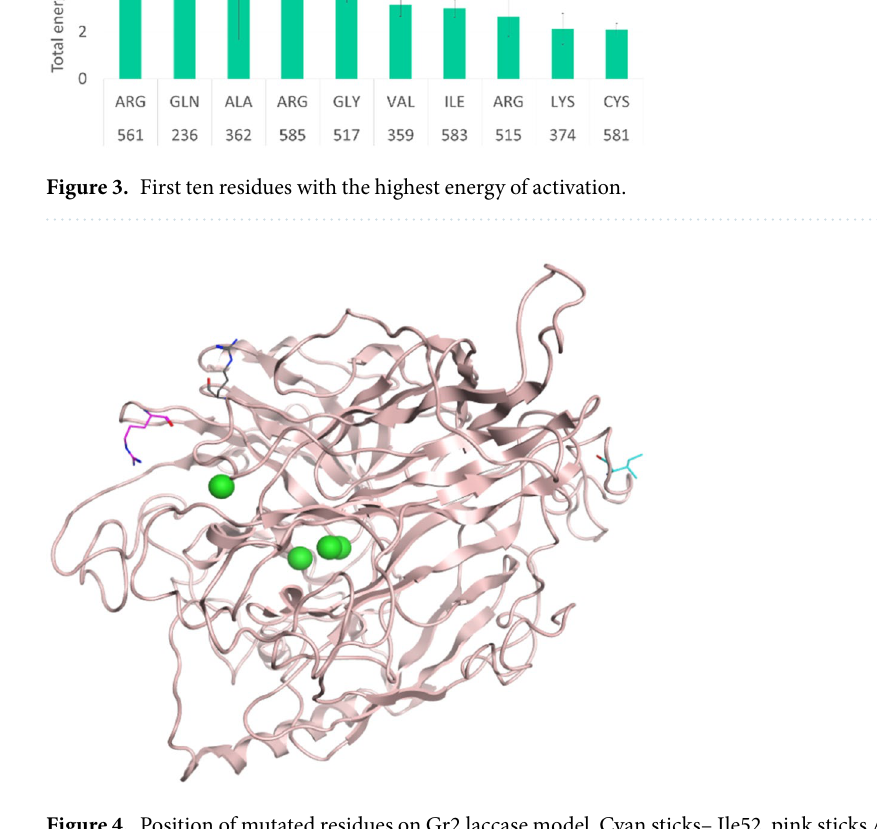
Figure 4. Position of mutated residues on Gr2 laccase model. Cyan sticks– Ile52, pink sticks Arg515, grey sticks– Arg561, green spheres – copper